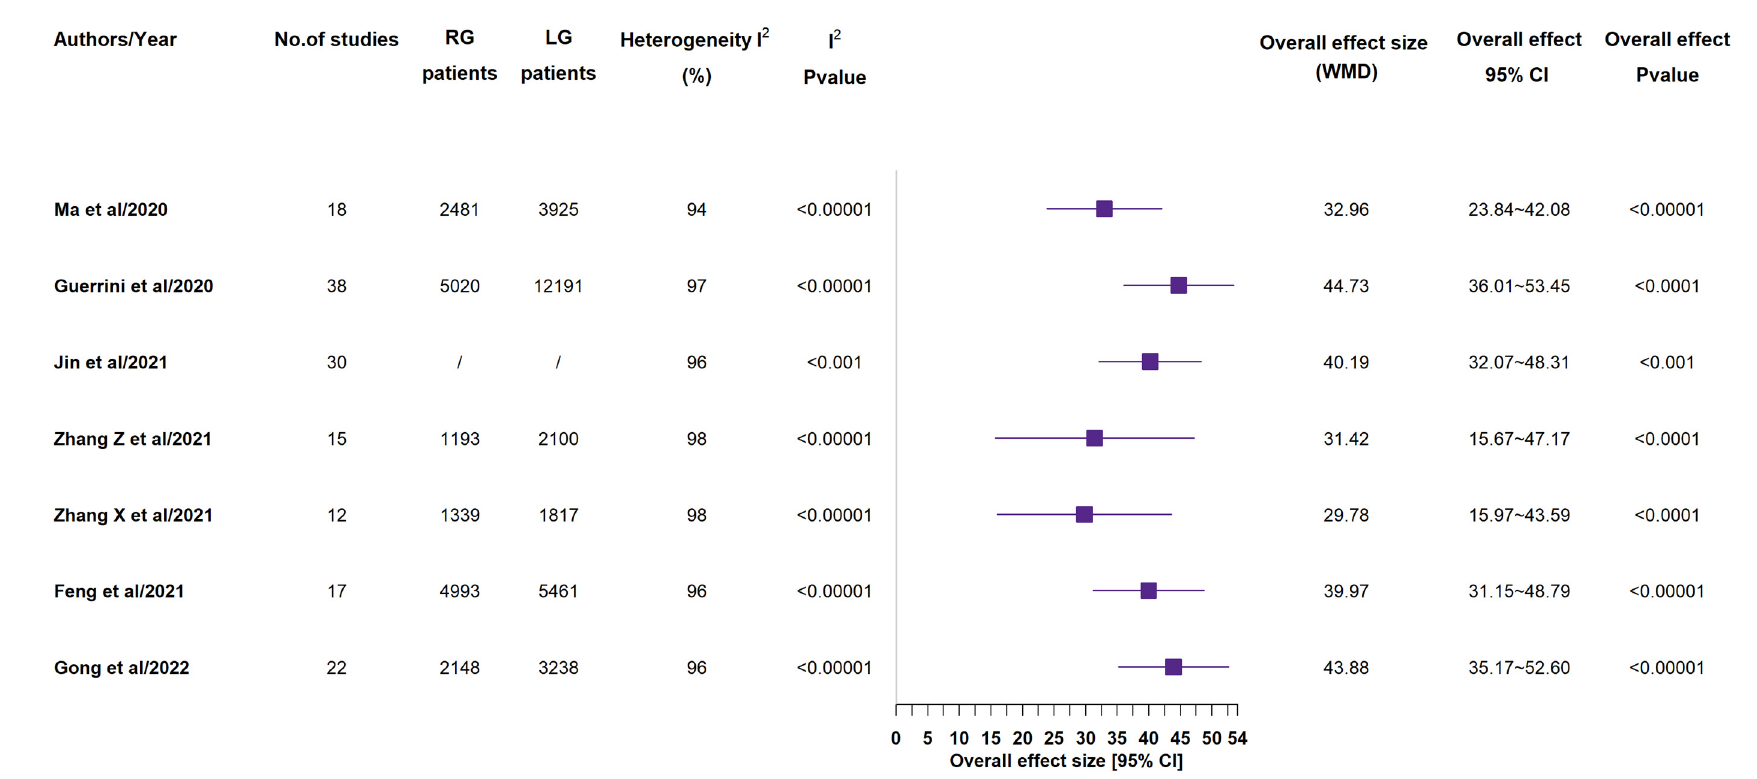
Figure 2. Operative time (min). RG = Robotic gastrectomy; LG = Laparoscopic gastrectomy; WMD = weighted mean difference